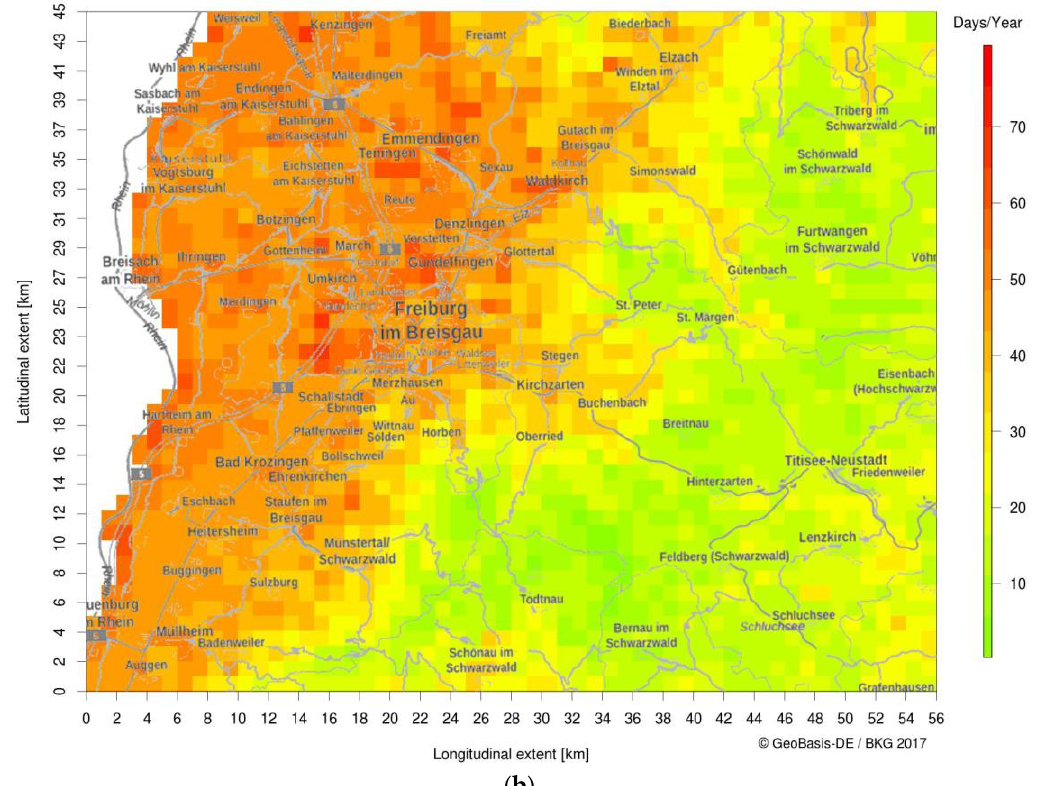
Figure 3. Spatial distribution of heat stress within the study area of southern Baden averaged over the time period 1995–2012: ( a ) heat stress days without consideration of acclimatisation effects (HS days) and ( b ) HS days with acclimatisation effects (HS ACC days).